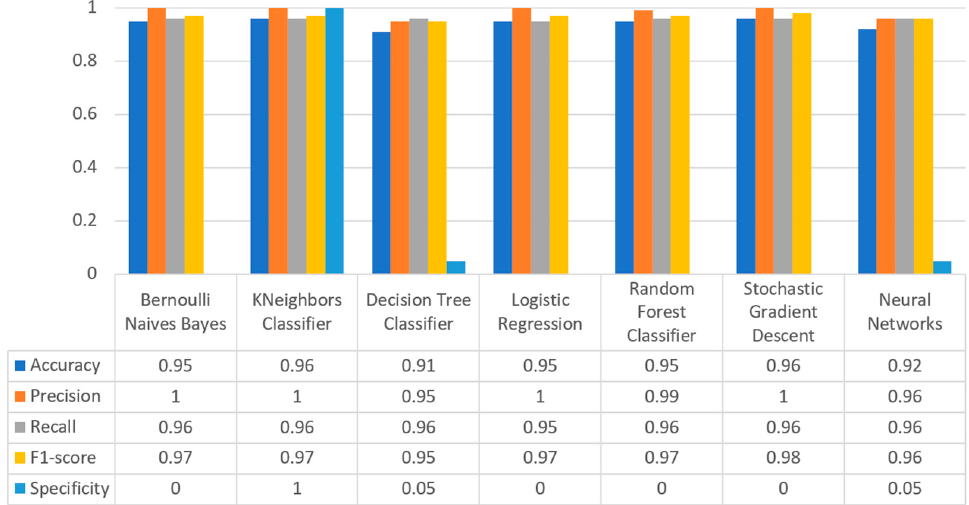
Figure 20. Performance comparison in the stroke use case.